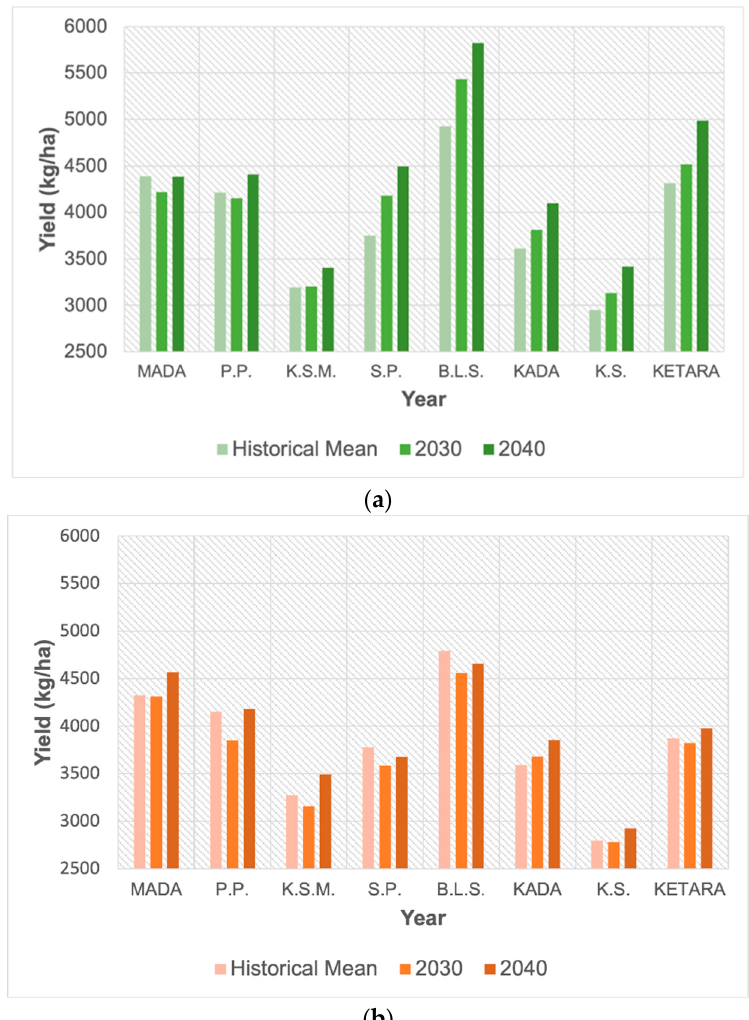
Figure 4. Forecasted yield in 2030 and 2040 relative to the sample means. ( a ) Main Season. ( b ) Off-Season. Based on Figure 4a,b, farmers in MADA, P.P., and K.S.M. would be the most affected